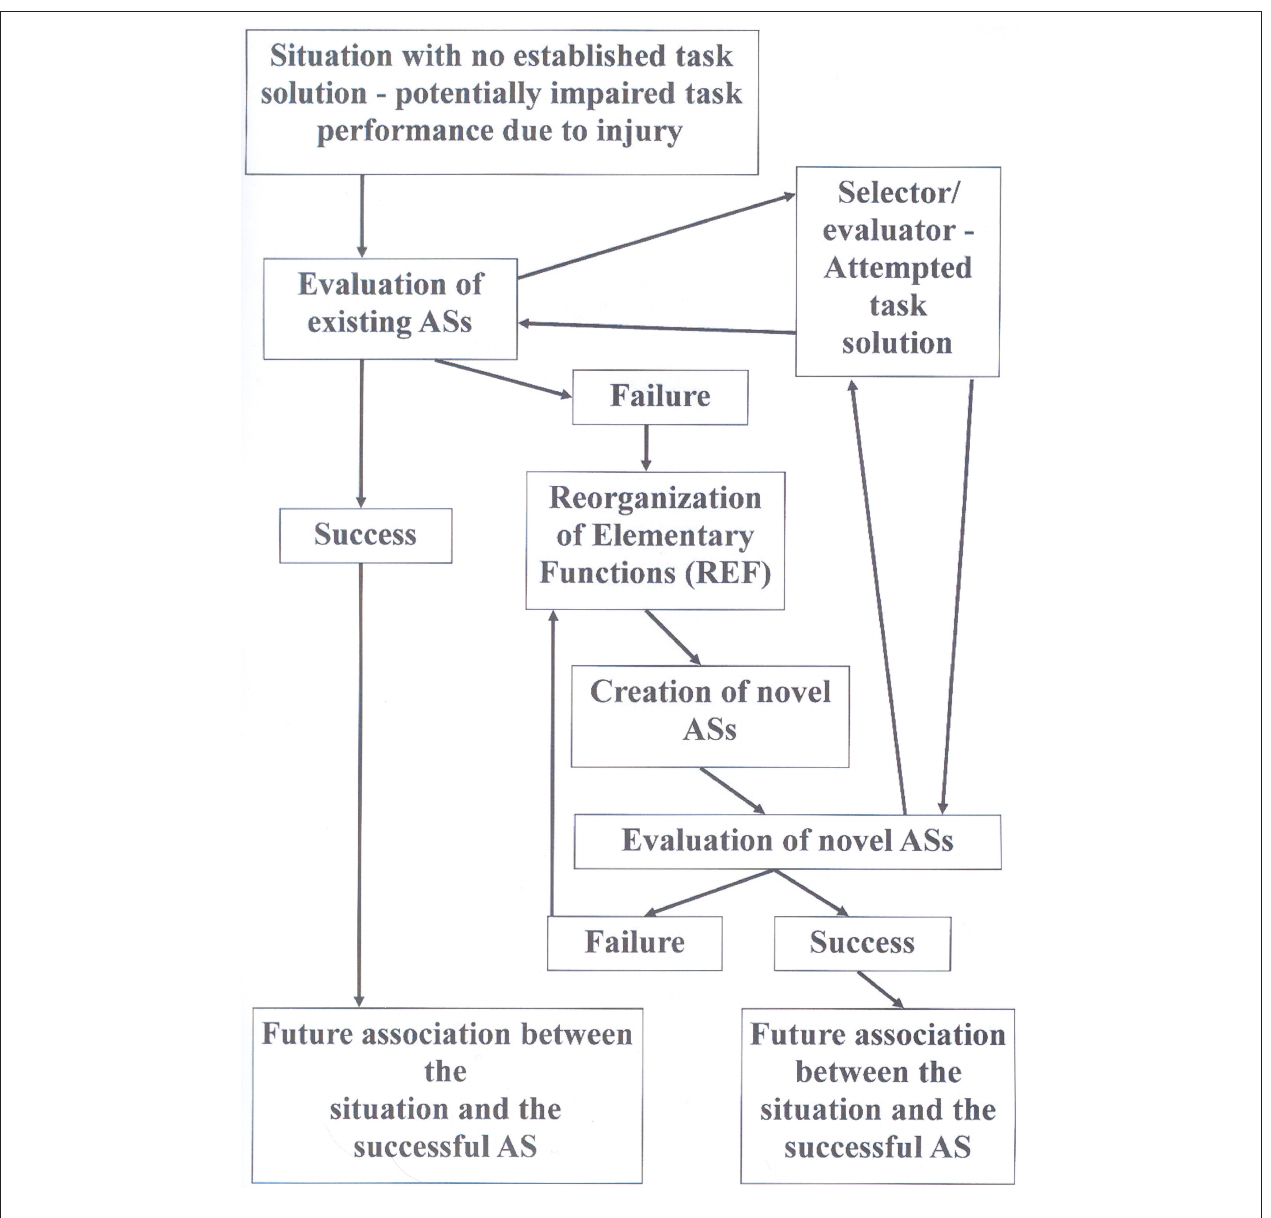
evaluator mechanisms. Additional plasticity modifying the connections between the neural substrates of EFs is only expected in case an actual Reorganization of Elementary Functions (REF) process is required. For further details: see the present text as well as Figures 3, 4, and 5 in Mogensen and Malá